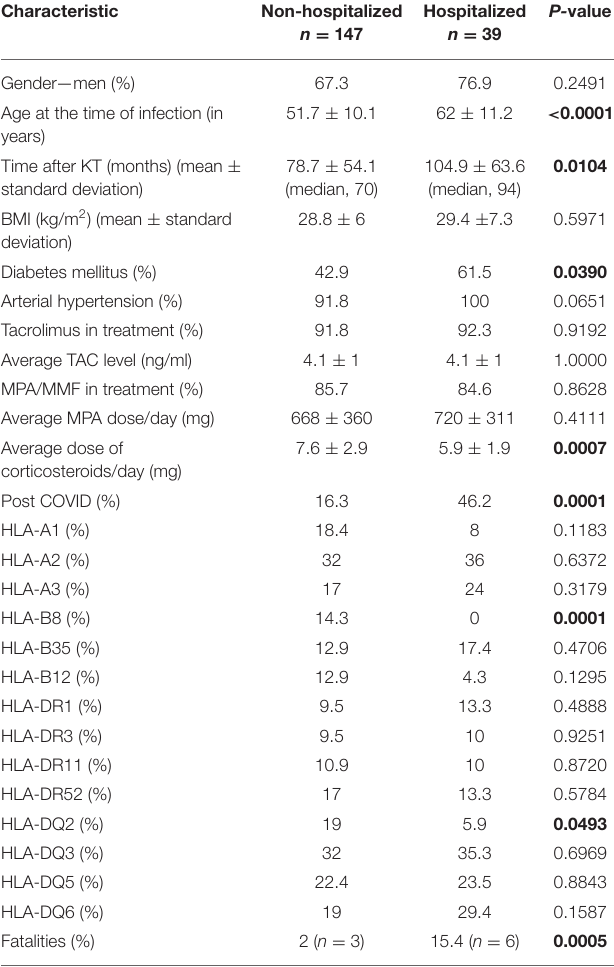
TABLE 1 | Basic group characteristics according to course of infection.